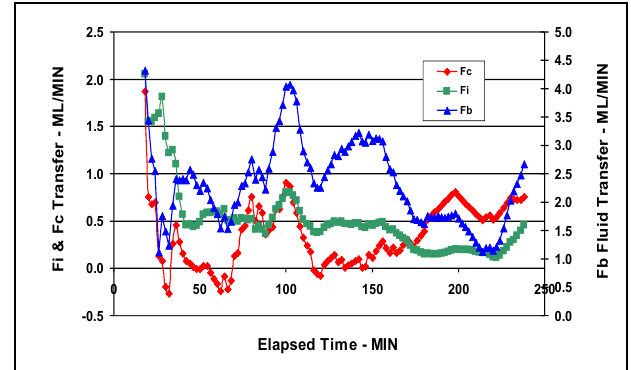
Fig. 7: Fluid transfer between compartment volumes during